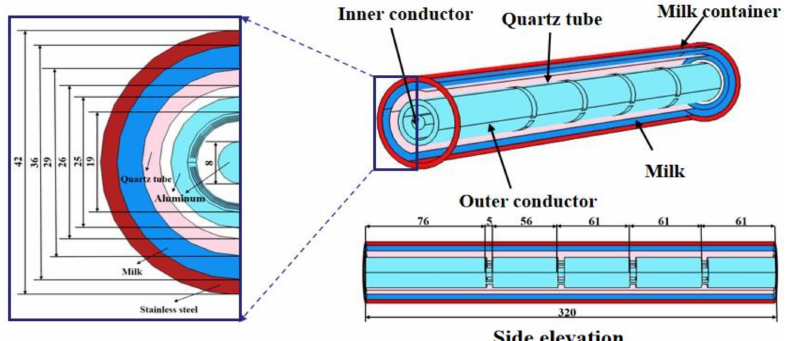
Figure 1. The geometry of the simulation model (unit: